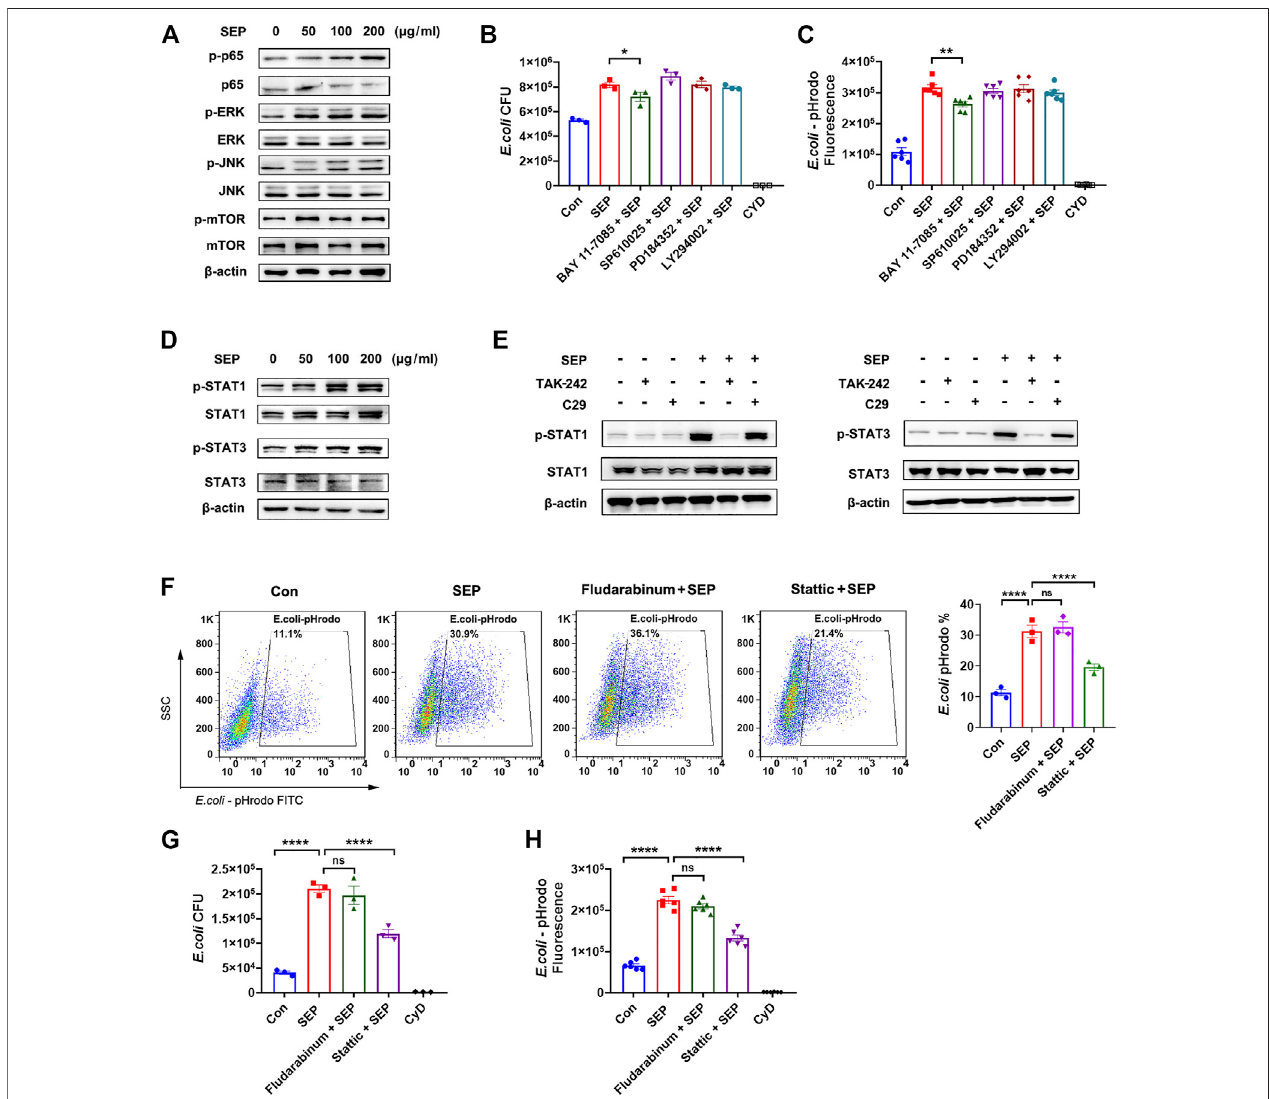
FIGURE 3 | TLR4/STAT3 signaling is involved in SEP induced phagocytosis. (A) The effects of SEP on protein levels of p-p65, p-ERK, p-JNK and p-mTOR were determined by western blot. (B) The effects of TLR4 signaling pathway inhibitors on phagocytosis of live E. coli were measured by gentamicin protection assay. RAW264.7 cells were pre-treated with NF- κ B inhibitor BAY 11-7085 (2 μ M), or JNK inhibitor SP610025 (5 μ M), or MEK1/2 inhibitor PD184352 (5 μ M), or PI3K inhibitor LY294002(5 μ M)for2 hpriortoSEPtreatment. (C) PhagocytosisofpHrodo- E.coli bymacrophageswerequanti fi edby fl uorescenceintensity. (D,E) Theeffectsof SEP on protein levels of p-STAT1, p-STAT3 were determined by western blot. The effects of Stattic (5 μ M) or Fludarabine (20 μ M) on phagocytosis of pHrodo- E. coli weremeasured by fl ow cytometry (F) ,or phagocytosis oflive E.coli by gentamicin protection assay (G) , or phagocytosis ofpHrodo- E.coli by fl uorescence intensity (H) . All data are represented as mean ± SEM acquired in triplicate determinations. * p < 0.05, ** p < 0.01, **** p < 0.0001.